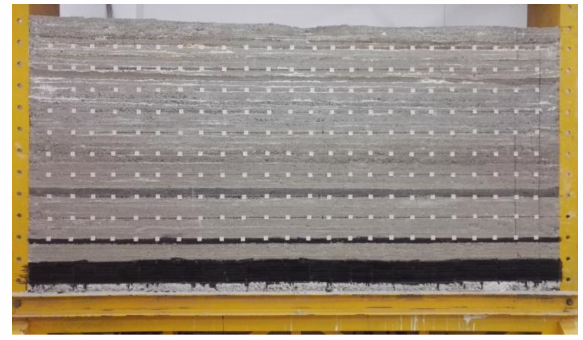
Figure 5. Physical analog